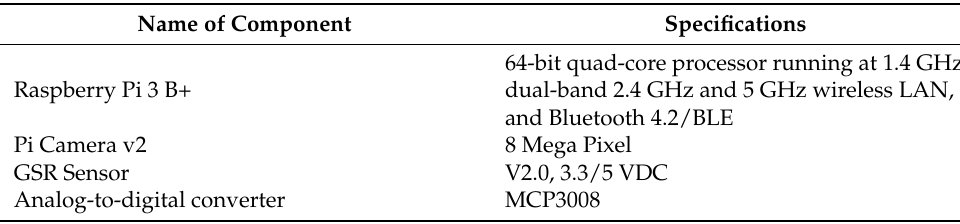
Table 2. Hardware